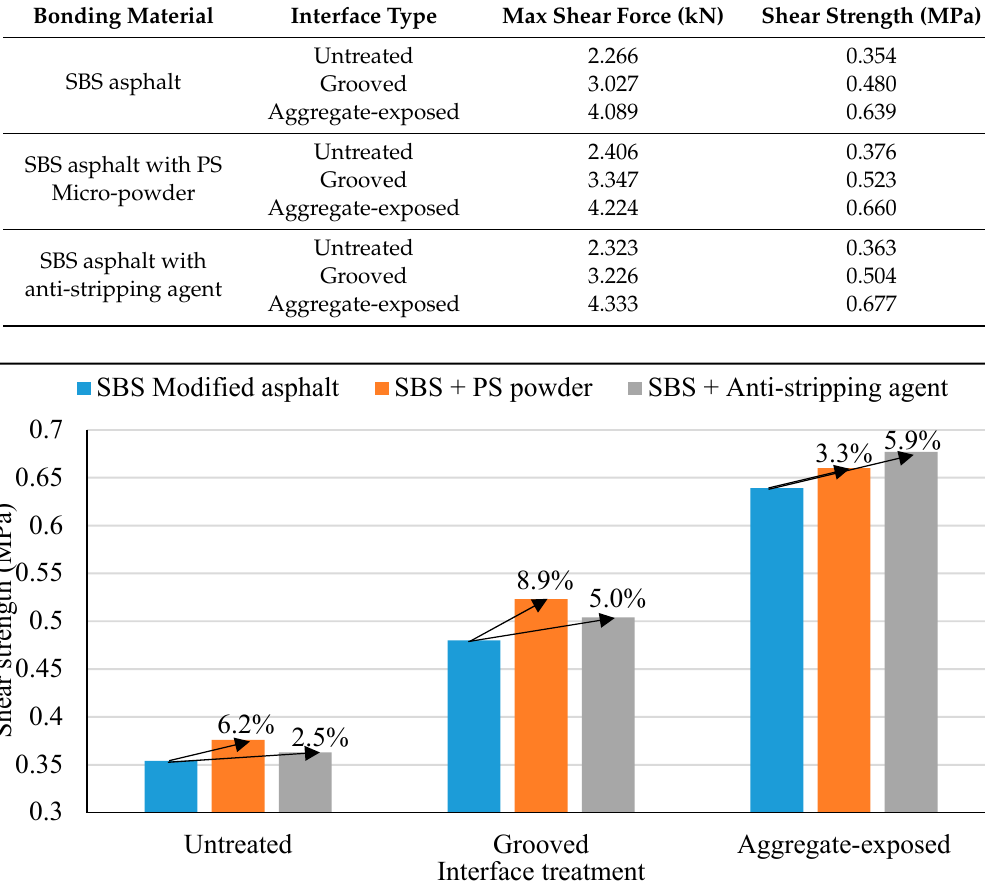
Figure 8. Interlaminar shear strength of different waterproof and cohesive materials.